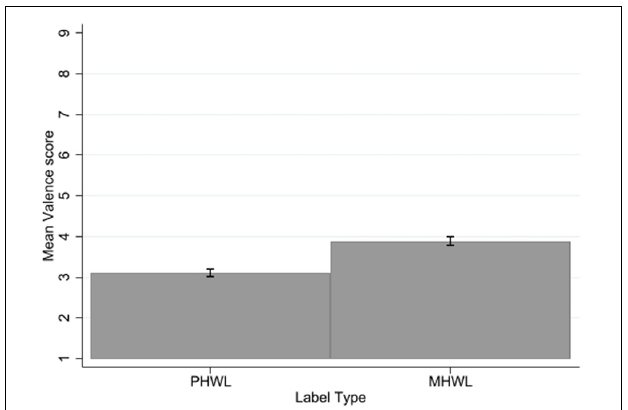
FIGURE 4 | Valence by label type. Error bars represent 95% confidence